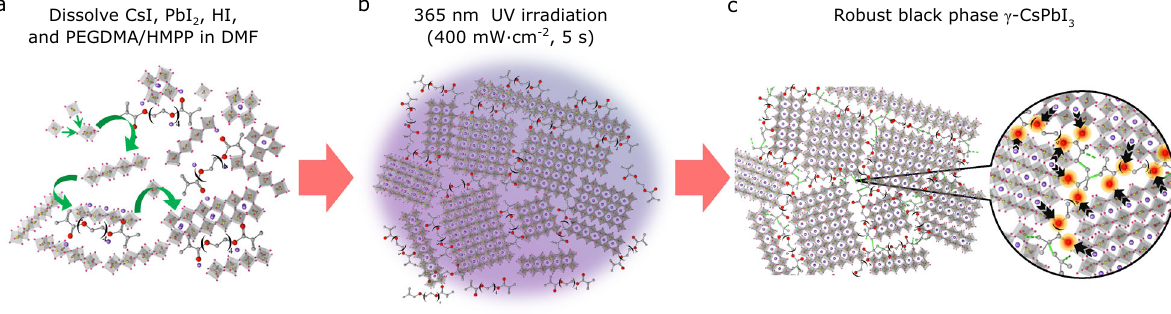
Fig. 2 A conceivable mechanism for the introduction of the PEGDMA UV-curing strategy to improve the long-term stability of CsPbI 3 . a Step 1: Induced CsPbI 3 nuclei formation and crystal growth from the PEGDMA molecular backbone chain by the PEGDMA ’ s oxygen lone pair electrons in the precursor solution. b Step 2: UV-curing process immediately before cooling, on the spin-coated and annealed CsPbI 3 after the addition of PEGDMA. UV irradiation: 365 nm, 400 mW cm − 2 for 5 s. c Step 3: Establishment of the robust γ -CspbI 3 with the UV-cured PEGDMA polymer with PEGDMA annealed at 90 °C for 5 min and exposed UV for 5 thin fi lm on the atmospheric stability of γ -CsPbI 3 . Figure 3 shows s immediately before cooling, which induces to photopolymeriza- the effect on the optical long-term stability of γ -CsPbI 3 by splitting tion between PEGDMAs, thus CsPbI 3 crystals in the thin fi lm the PEGDMA content added to the CsPbI 3 precursor solution into were fi xed more compactly without any extra byproducts (Fig. 2b). 0, 0.5, 1, 3, and 5 wt%, respectively. For convenience, the group of γ -CsPbI fi lm samples with adding different wt% of PEGDMA 3 thin- cured by UV after spin coating are brie fl y referred to as γ -CsPbI 3 fi xed by the UV-cured (0, 0.5, 1, 3, and 5 wt% PEGDMA), respectively. Figure 3a – e is the 3 structure, which is tightly PEGDMA polymer network, can maintain the robust γ -phase result of accumulating UV-vis absorbance spectra while exposing γ -CsPbI under ambient conditions (Fig. 2c). 3 (0, 0.5, 1, 3, and 5 wt% PEGDMA) to the ambient con- ditions for 35 days. The variation of an optical property of γ -CsPbI 3 (0, 0.5, 1, 3, and 5 wt% PEGDMA) for 35 days were measured at ambient conditions with 20.50 ± 1.10 °C for temperature and 26.81 ± 2.56% for relative humidity, respectively (Supplementary